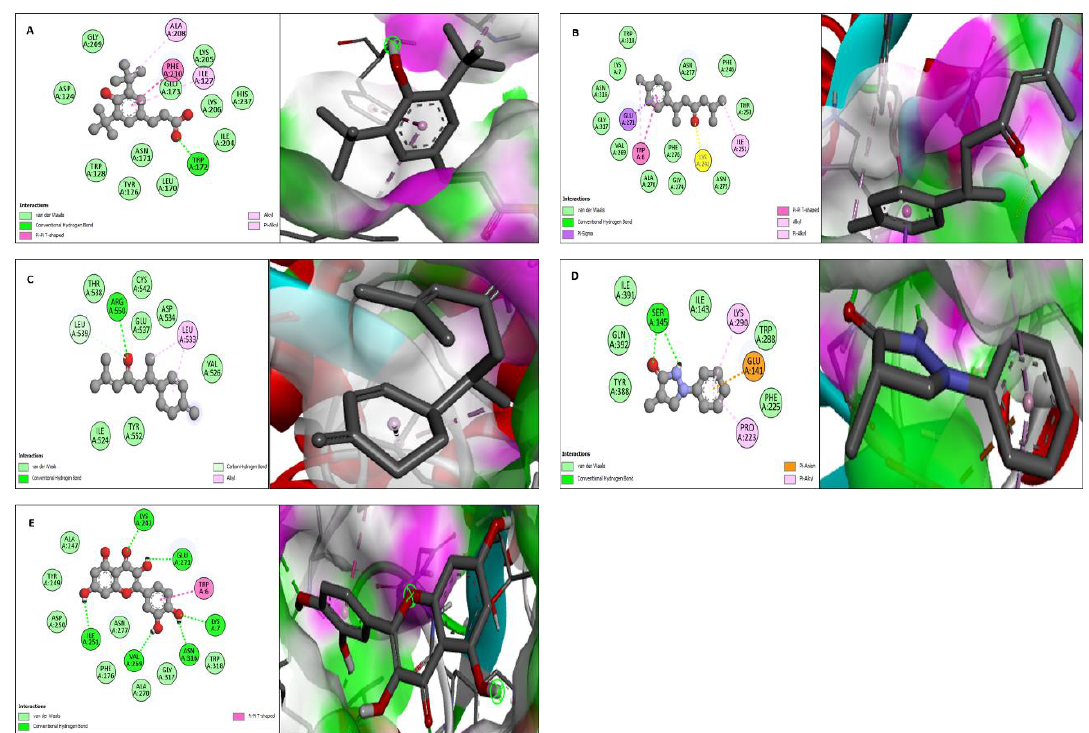
Figure 5. 2D and 3D interaction of α-glucosidase with ligands. ( A ) Benzenepropanoic acid, 3,5-bis(1,1-dimethylethyl)-4-hydroxy-, methyl ester, ( B ) ar-Turmerone, ( C ) Curlone, ( D ) 3-pyrazolidinone, 4,4-dimethyl-1-phenyl and ( E ) Quercetin.